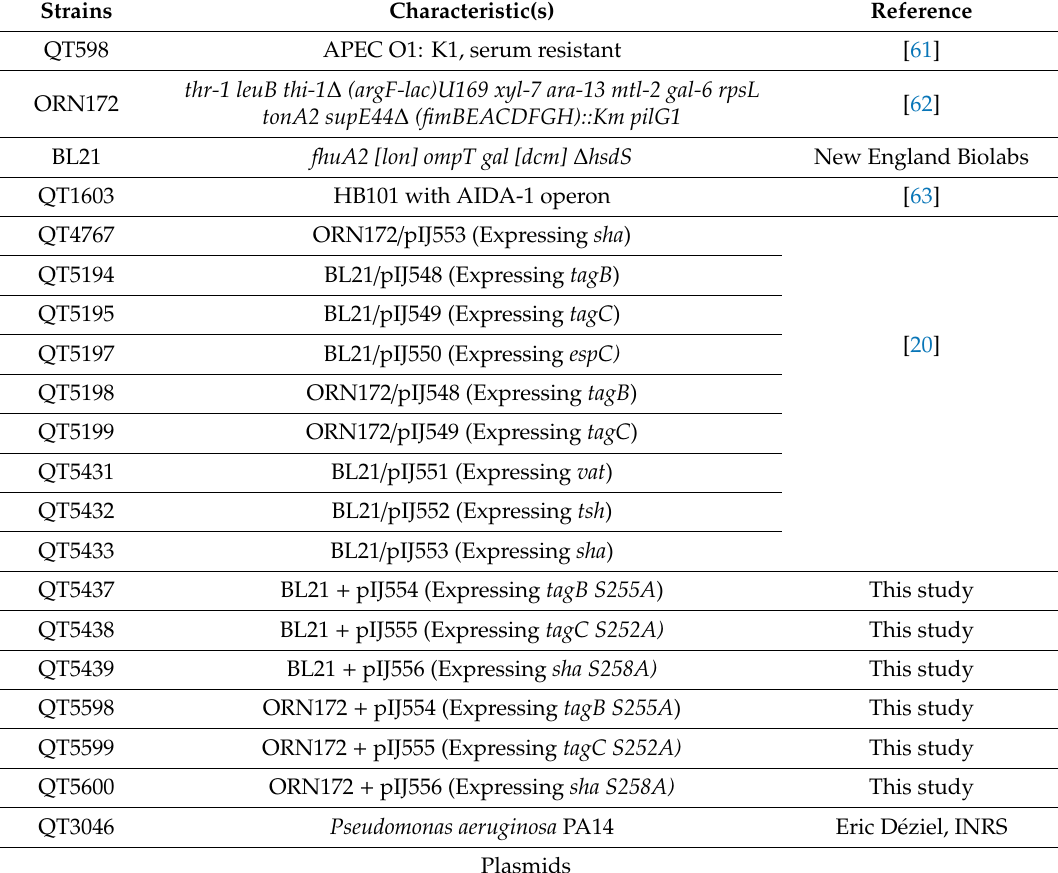
Table 1. Strains and plasmids used in this